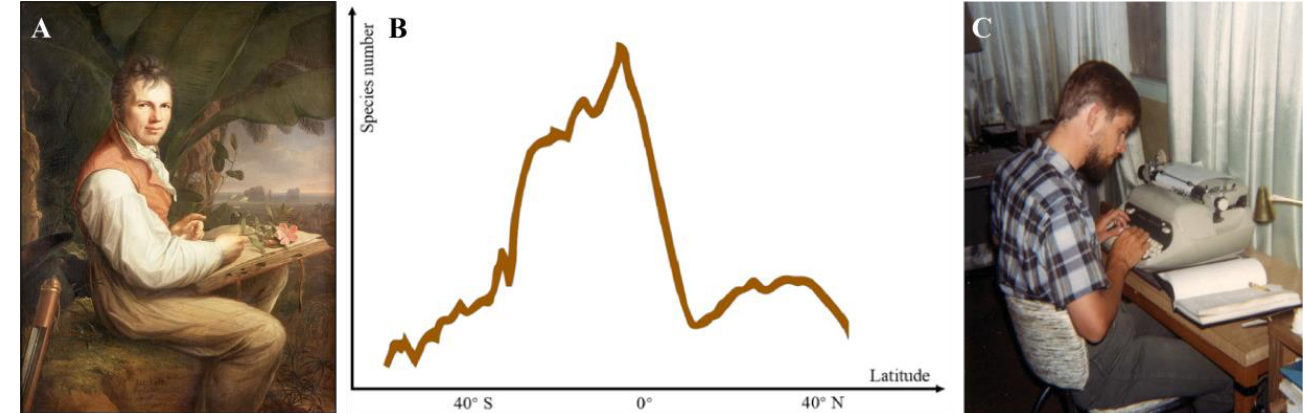
Figure 1. ( A ), Alexander von Humboldt (1769–1859) is widely regarded as the “father of phytog- raphy”. He was the first to state observations about the LDG (photo reproduces from Biogeog- raphy [19]); ( B ), diagram of the LDG, with count of species by latitude (diagram adapted from Spatio-temporal climate change contributes to latitudinal diversity gradients [9]); ( C ), Eric Pianka provided insights into the concept and major hypotheses for the LDG in 1966 (Photo courtesy of E. Pianka on 23 February 2022 via Email; this photo has also been used in Am. Nat . 2017